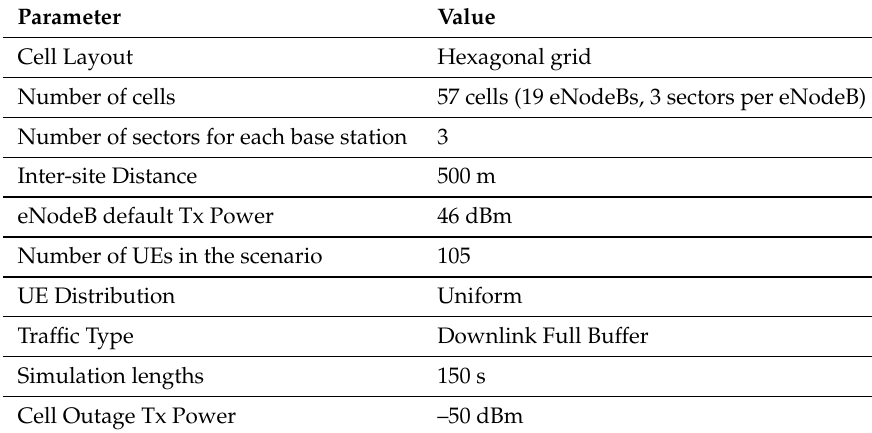
Table 1. Simulation parameters.